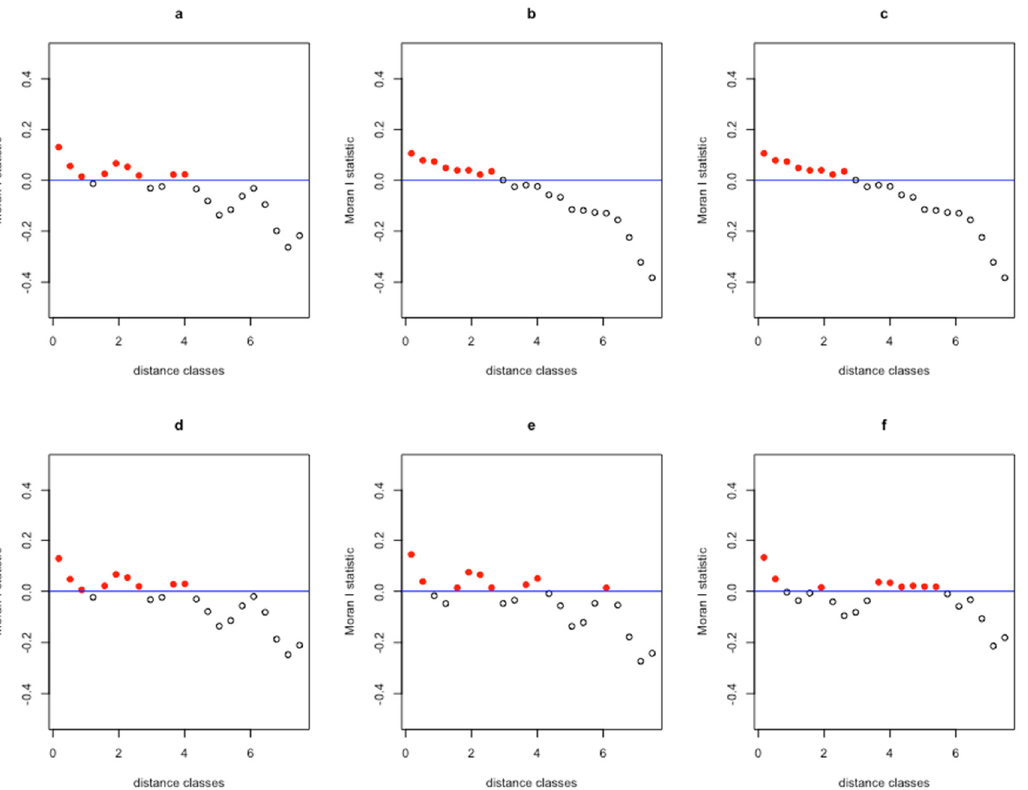
Figure 4. Correlation of residuals of six candidate models fitted to NEAMAP weakfish survey data. Highlighted dots represent significant values, and 1 distance class refers to 100 km (( a ) residuals from delta GLM; ( b ) residuals from delta GAM; ( c ) residuals from delta spatial GAM; ( d ) residuals from delta SAR error model; ( e ) residuals from delta SAR lag model; ( f ) residuals from delta SAR mixed model).